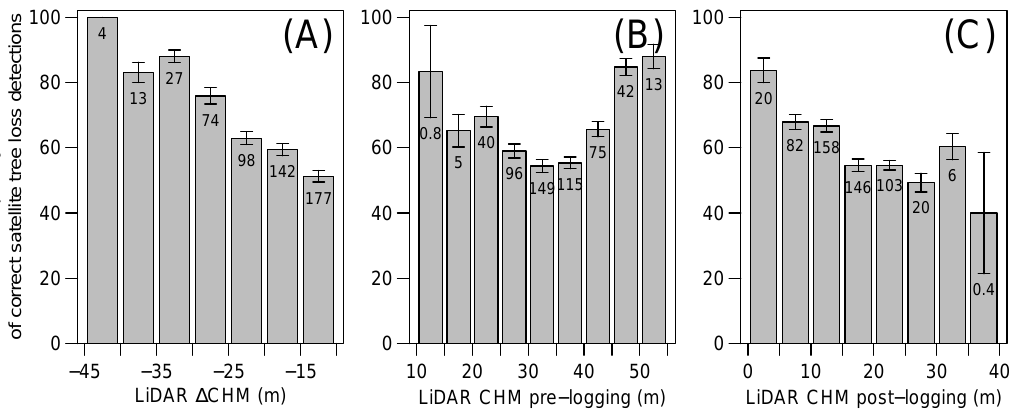
Figure 5. Relative frequency of correct satellite tree loss detections for intervals of ( A ) LiDAR CHM height differences ( ∆ CHM), ( B ) LiDAR CHM pre-logging, and ( C ) LiDAR CHM post-logging. Mean and error bars (95% confidence interval) were calculated considering the 30 model runs. Numbers inside bars represent the average number of ITCs within that class among the 30 model runs.